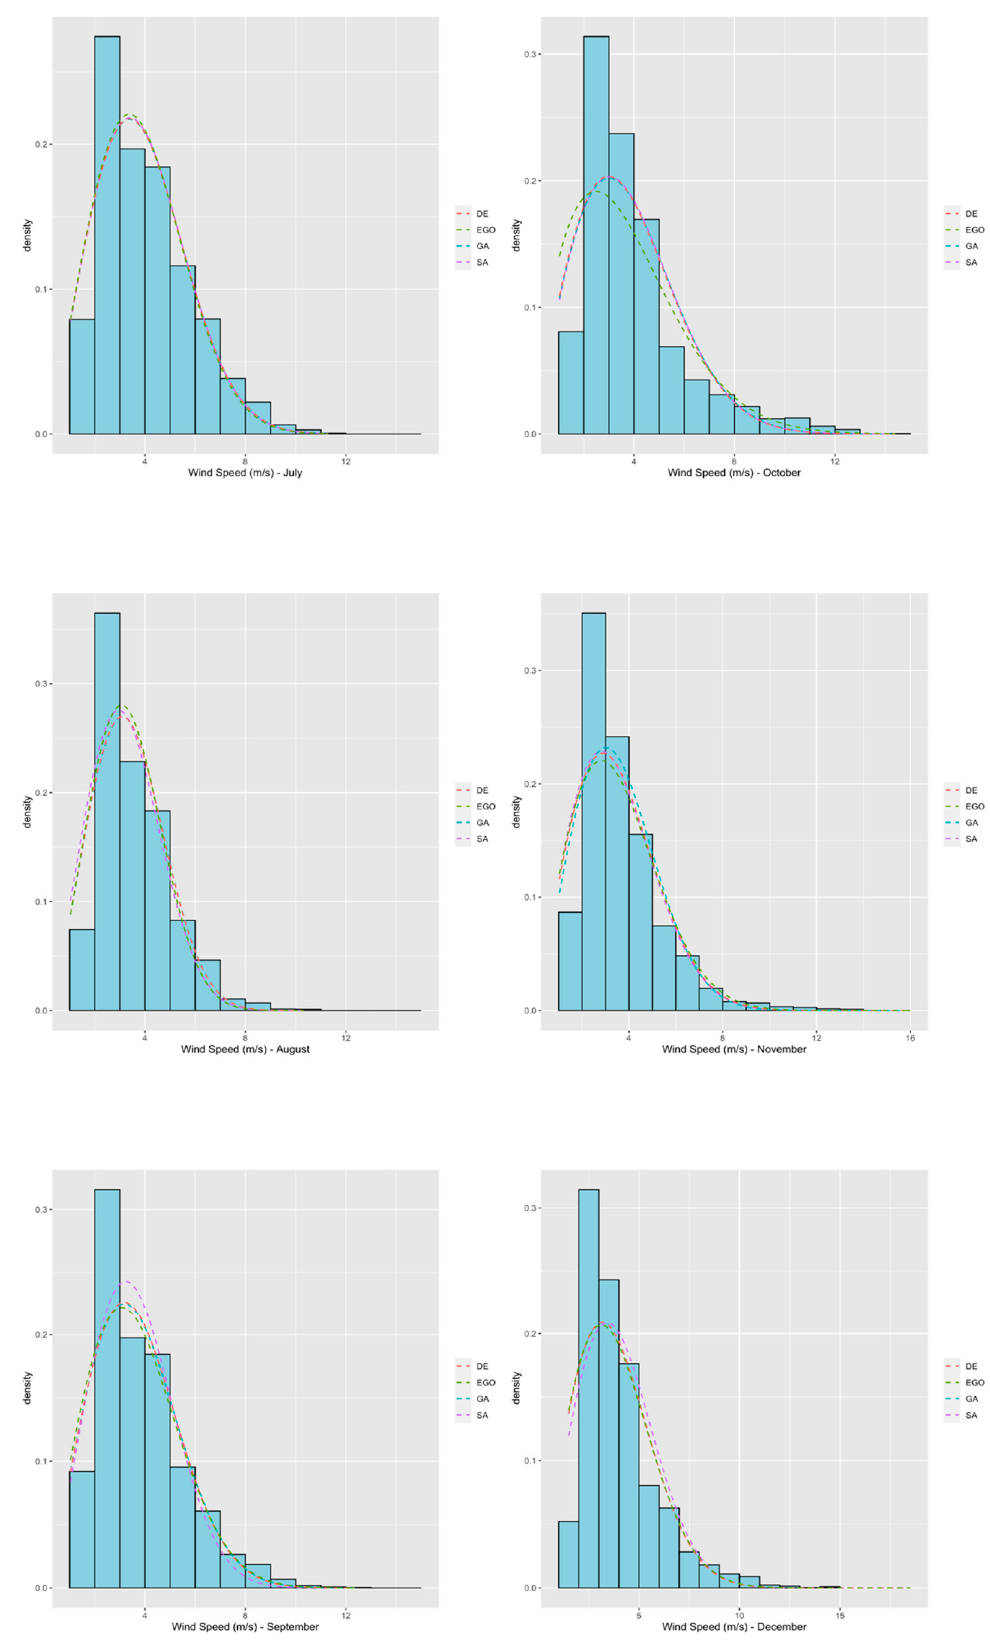
Figure 9. Monthly probability density function estimation and monthly histograms of observed WS data (from July to December) (own elaboration).